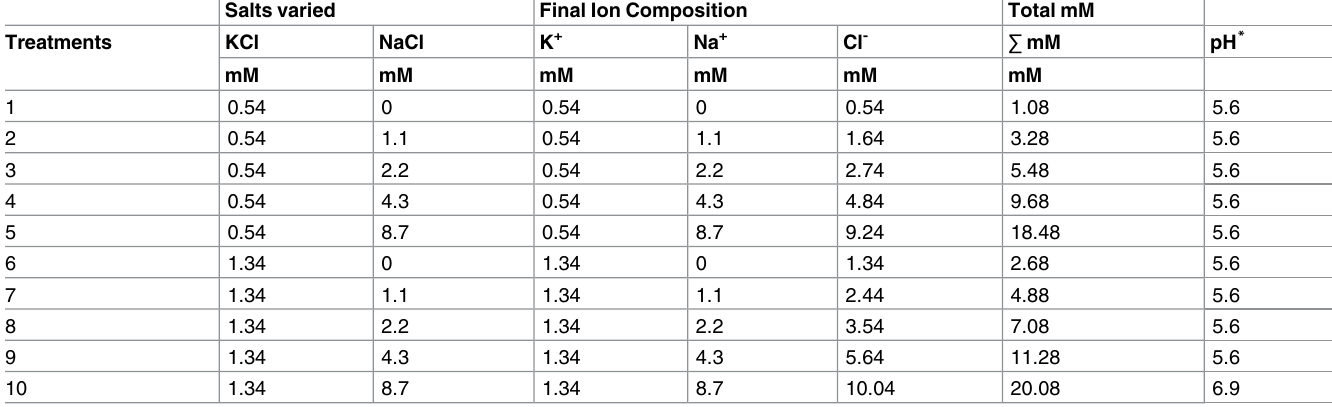
Table 1. Deconstructing the experiment of Krishnasamy et al. [14] to determine the effects of K + and Na + into the actual ion levels. The experiment varied three ions K + , Na + , and Cl - . The effects of K + and Na + are confounded with those of Cl - . Salts varied